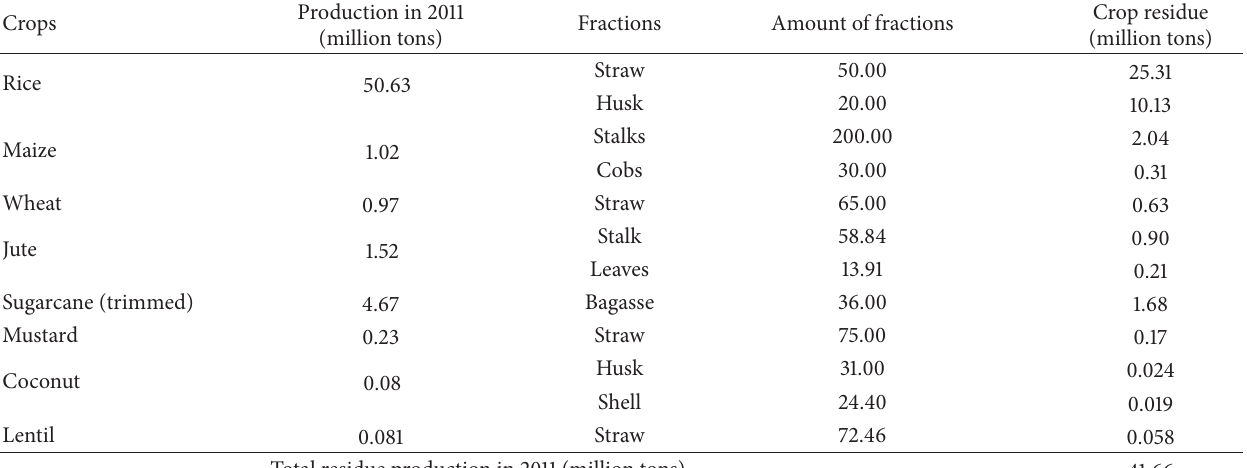
Table 3: Total residue production with percentage of fractions of some selected agricultural crops.